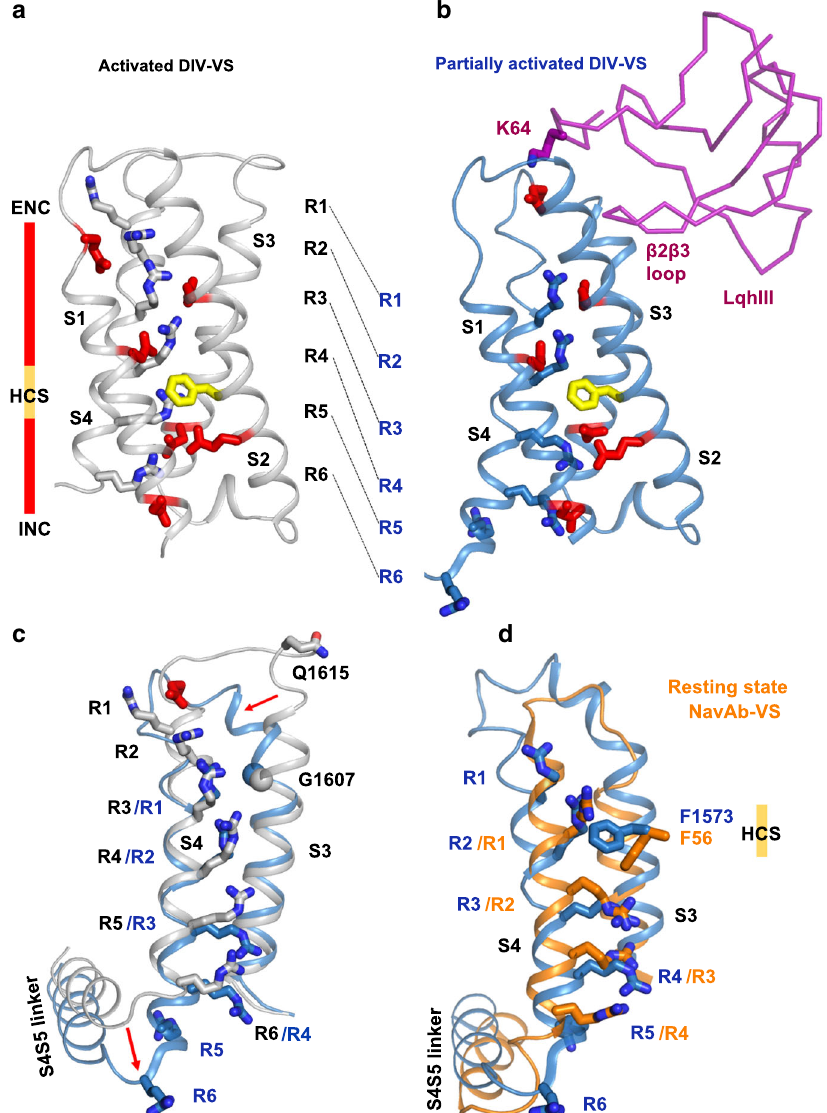
Fig. 4 Conformational Change of D IV-VS. a , b Structures of the activated Na V 1.5 D IV-VS and intermediate-activated Na V 1.5 D IV-VS were colored in grey and blue, respectively. Gating charges (grey or blue), ENC (red), HCS (yellow), and INC (red) were shown in sticks. The shift of each gating charge was indicated by black dashed lines. c Superposition of Na V 1.5 D IV-VS between activated and intermediate-activated state. Red arrows indicate the conformational changes. d Superposition of the intermediate-activated Na V 1.5 D IV-VS and resting-state Na V